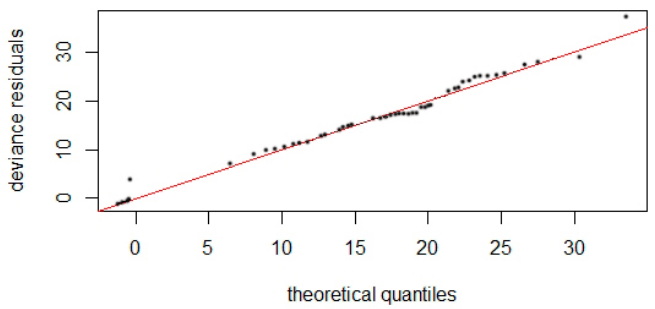
Figure 4. Quantile–quantile plot with Tweedie response distribution and the variables depth and distance from 200 m isobaths.